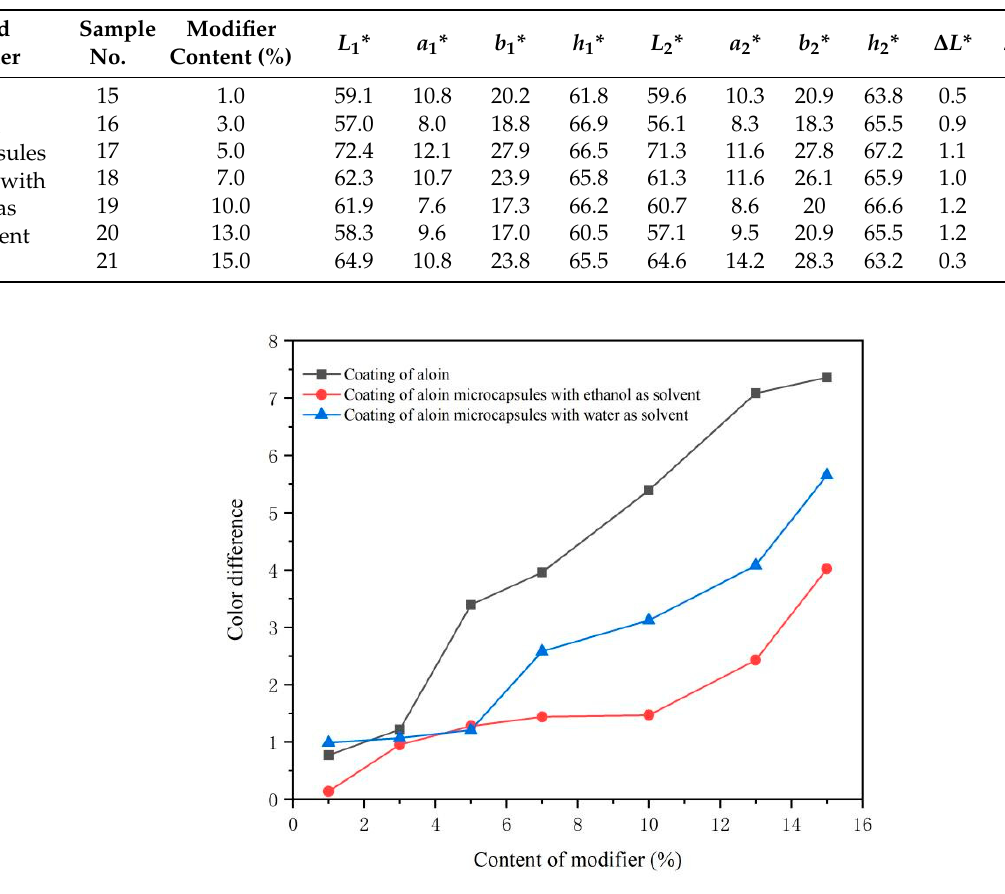
Figure 4. Color difference of coating surface with different content of modifier.